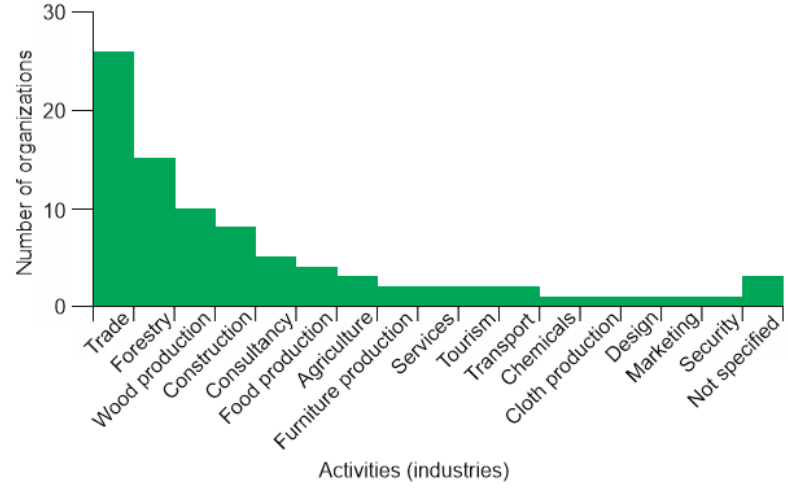
Figure 3. Industry affinity of the firms using Siberian cedar in their names.